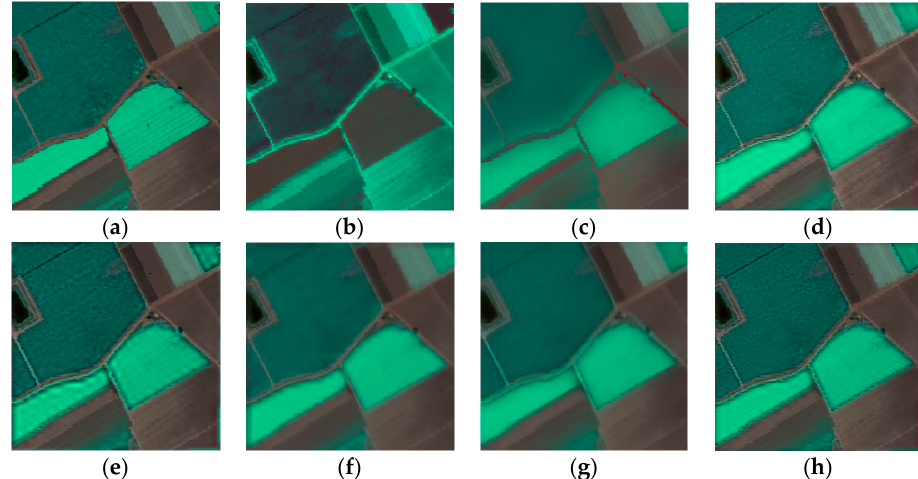
Figure 5. Visual comparison of different hyperspectral pansharpening methods for Salinas dataset. ( a )Reference; ( b ) PCA; ( c ) GFPCA; ( d ) HySure; ( e ) MGH; ( f ) CNMF; ( g ) Sparse Representation; ( h ) Proposed.